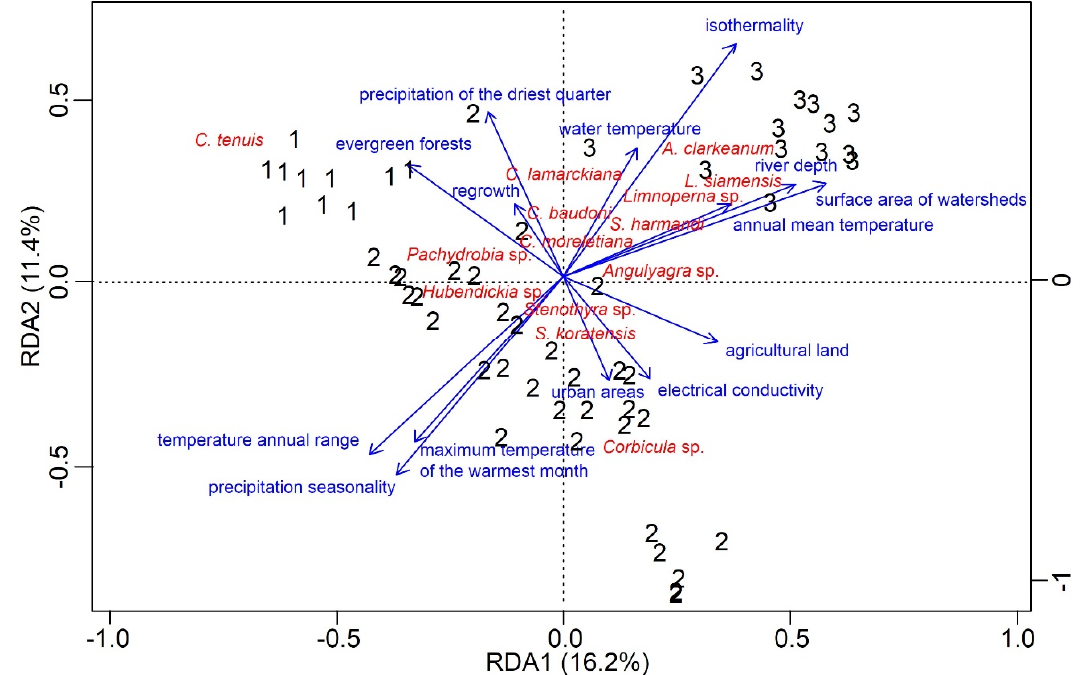
Figure 5. Redundancy analysis (RDA) ordination plot illustrating the key driving factors (after eliminating less important variables) of mollusc communities in each cluster. Each number represents each cluster of sites.